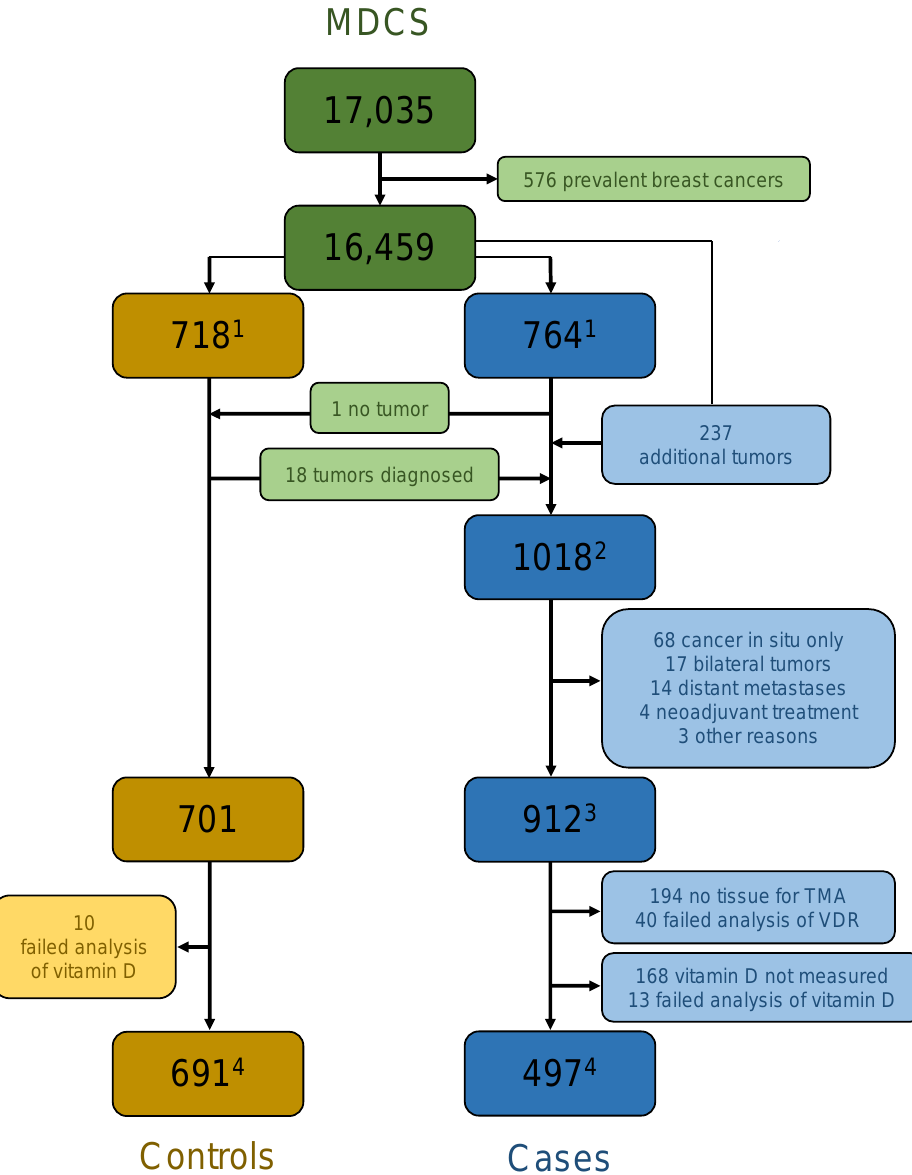
Figure 1. Flowchart of study population, inclusion, and exclusion criteria. 1 Cases until end 2006 and controls in study with vitamin D levels measured. 2 Cases until end 2010. 3 Cases included in TMA. 4 Cases and controls with information on vitamin D level and VDR expression.